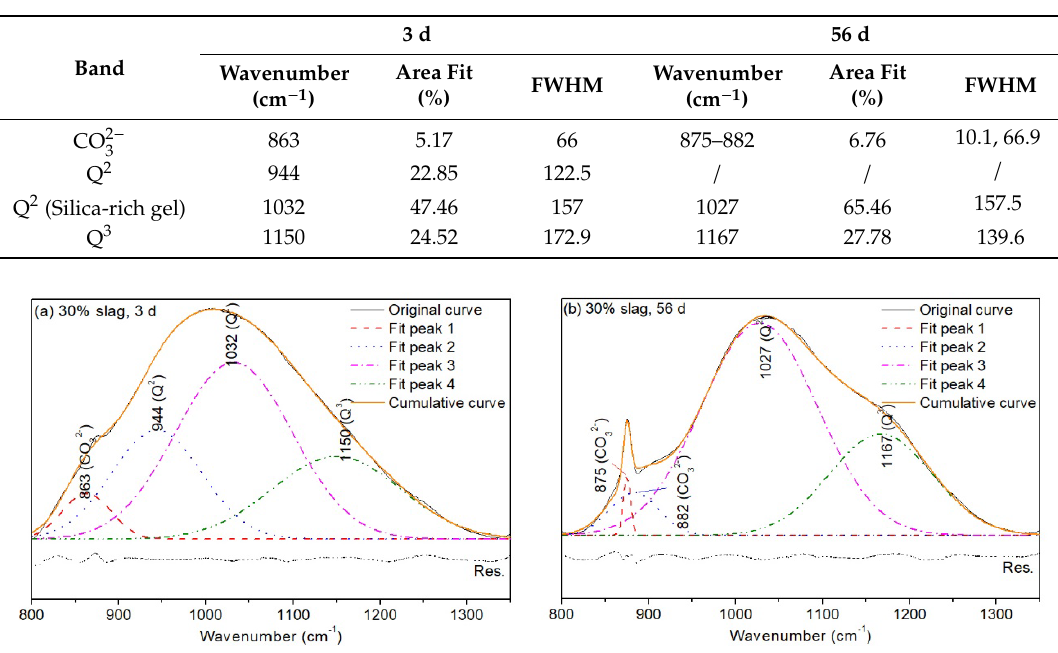
Figure 11. Deconvolution of Si–O band ranging from 800 to 1350 cm − 1 of alkali activated LFA-GGBS hybrid binders with di ff erent GGBS content at di ff erent ages (Na 2 O content 10%, n = 1.6, and w / s = 0.4): ( a ) 30% GGBS, 3 d; ( b ) 30% GGBS, 56 d.